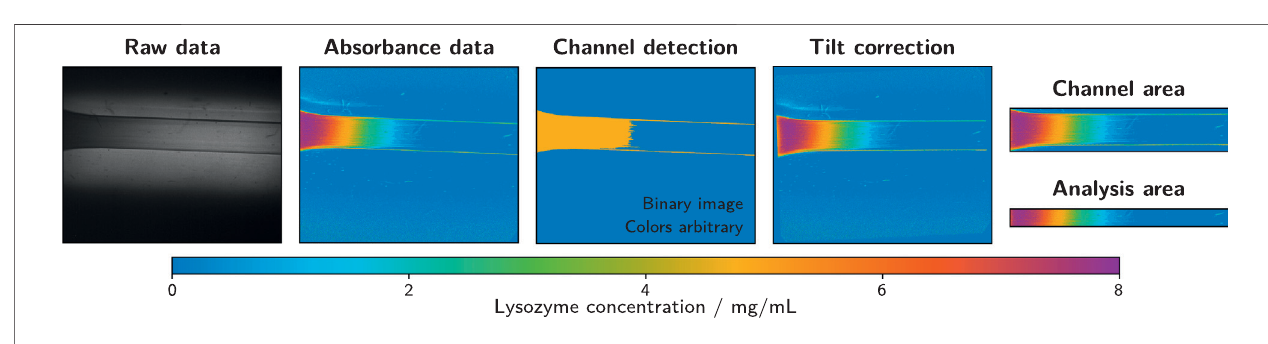
FIGURE 3 | Image processing steps as performed with the ActiPix ™ software and MATLAB . The example shows the last frame of a measurement with 10 mg/ml lysozyme as the analyte solution and 1.5% (w/w) low-melt agarose as the hydrogel. Raw data fi les were converted to absorbance data using the ActiPix ™ software. In MATLAB , the channel was detected based on the last frame ofthe measurement tocorrect for inaccuracies in positioning and alignment. Based on the channel detection, the tilt was corrected and the channel area extracted. An area of 100 pixels in height was taken from the middle of the channel and used as the analysis area.